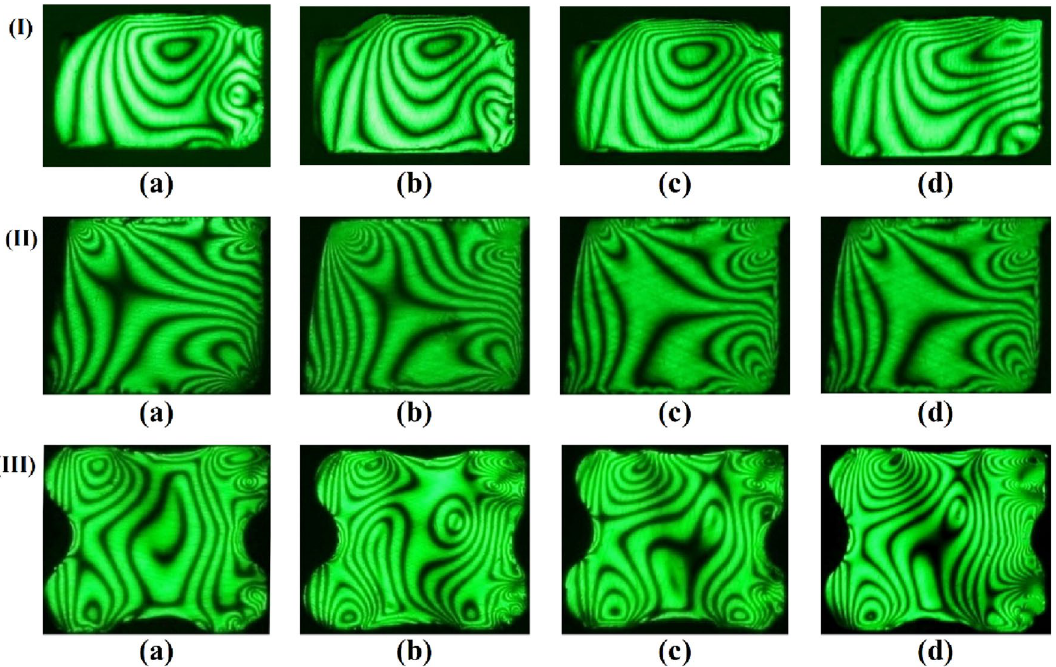
Figure 7. The isochromatic fringe patterns of (I) D-ring, (II) square ring, and (III) X-ring were obtained using the photoelastic experimental rig at different internal pressures. ( a ) Pi =1.0 MPa ( b ) Pi =2.0 MPa ( c ) Pi =3.0 MPa ( d ) Pi =4.0